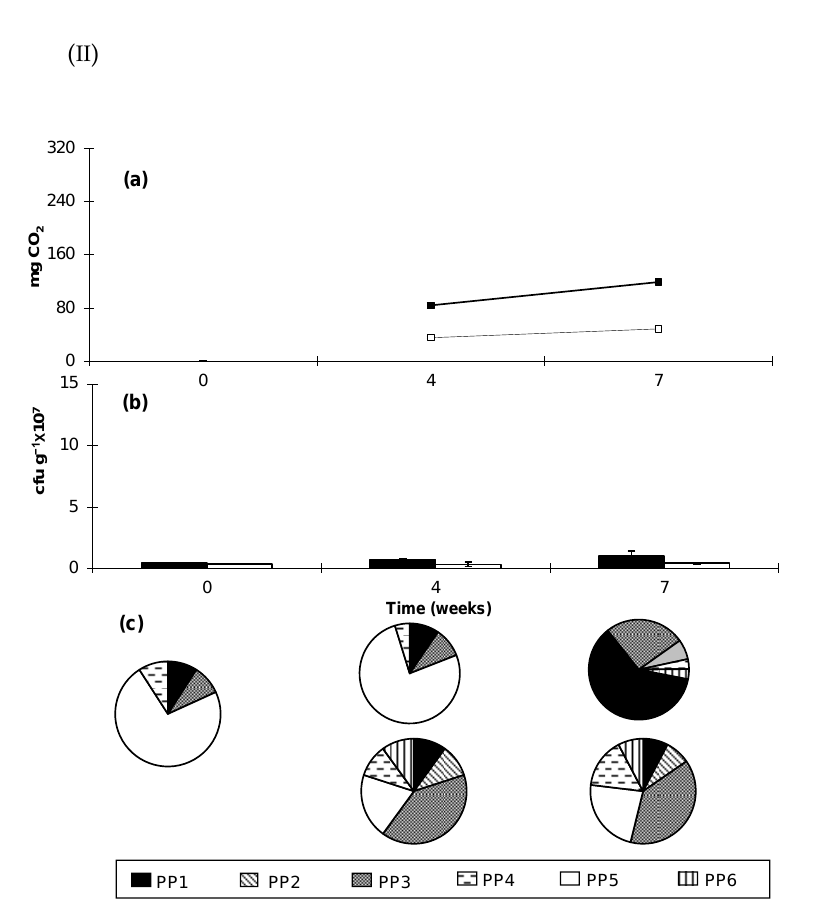
Figure 3. Results regarding ( a ) soil respiration (average ± se), ( b ) abundance of the community of culturable bacteria (average ± se) and ( c ) relative participation of the isolated main bacterial strains in enriched with α-pinene (P) and in control soil samples, from ( I ) an oak forest (O) and ( II ) phrygana (P). α-Pinene was added every week. Measurements for ( b , c ) were taken at the start of the experiment and then on the 4th and 7th week; measurements for ( a ) started on the 4th week. In ( a , b ), white colour corresponds to control soil samples and grey to enriched ones. In ( c ), the upper row corresponds to treated samples and the lower to control samples. For the bacterial codes, see note 1 under Table 2.